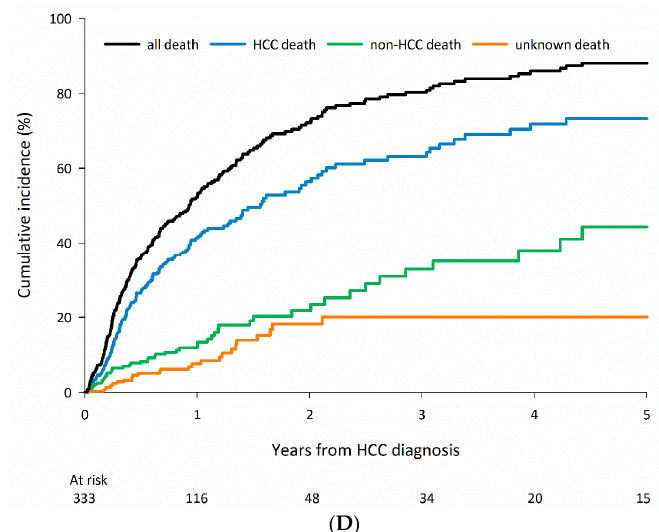
Figure 5. Cumulative mortality risk for hepatocellular carcinoma among patients who received non-curative treatments according to chronic liver disease etiology: ( A ) hepatitis C virus; ( B ) hepatitis B virus; ( C ) alcohol use; and ( D ) all negative (defined as no evidence of virus infection or alcohol use).